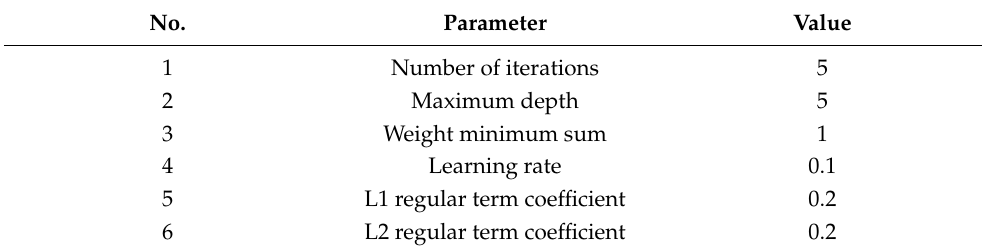
Table 7. Parameter configuration of